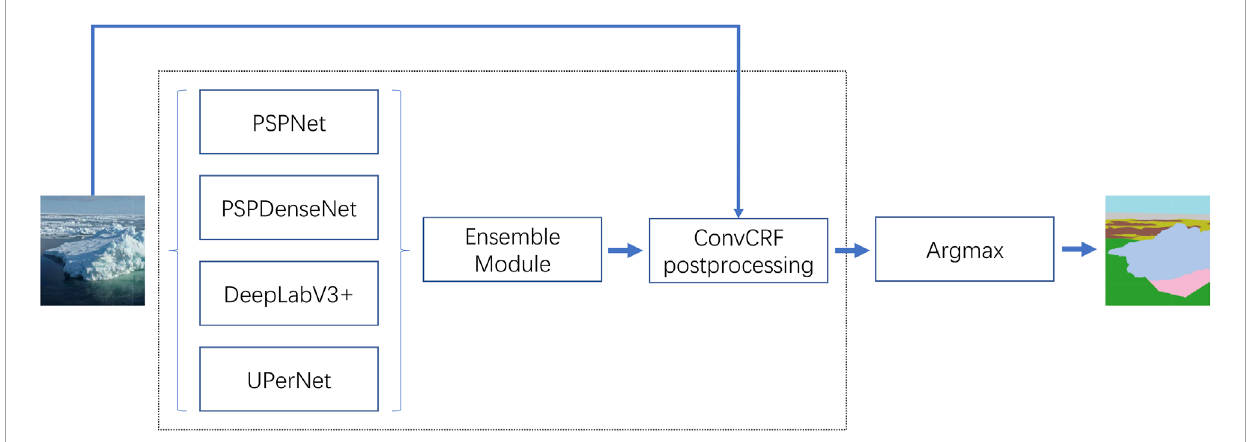
FIGURE 5 This figure shows a flow chart of sea ice identification by feature fusion. Four models, PSPNet, PSPDenseNet, DeepLabV3+, and UPerNet, generate different feature maps and perform feature fusion. The synthesized feature maps are then passed through the ConvCRF post-processing layer to achieve the recognition of rich sea ice. Adapted from Figure 5 of (Panchi et al.,